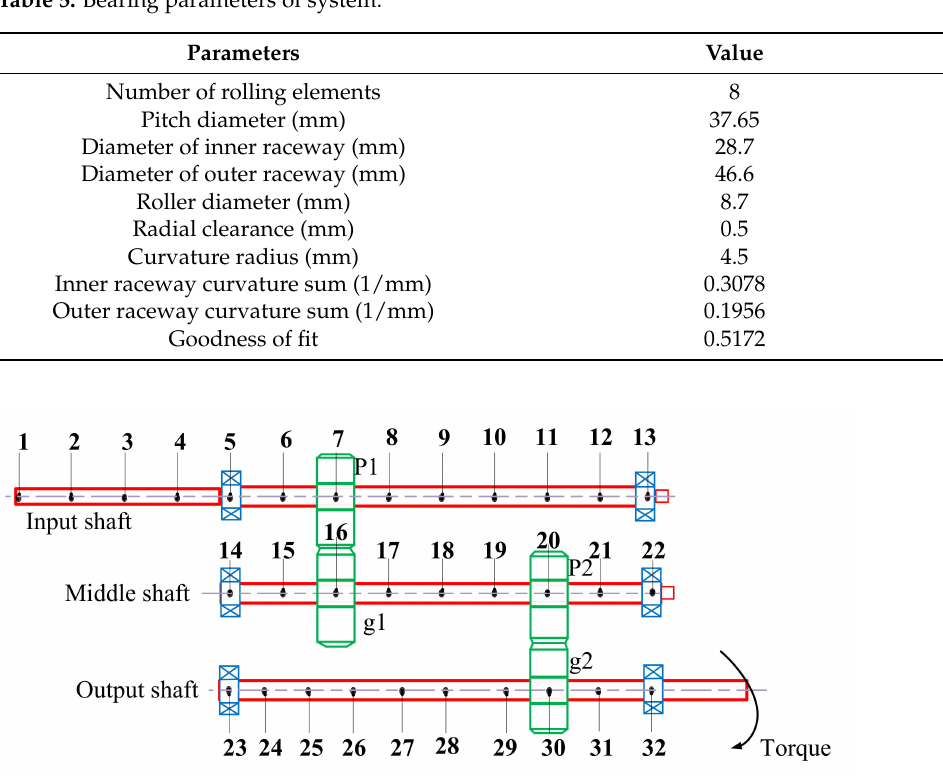
Figure 17. Finite element model of transmission